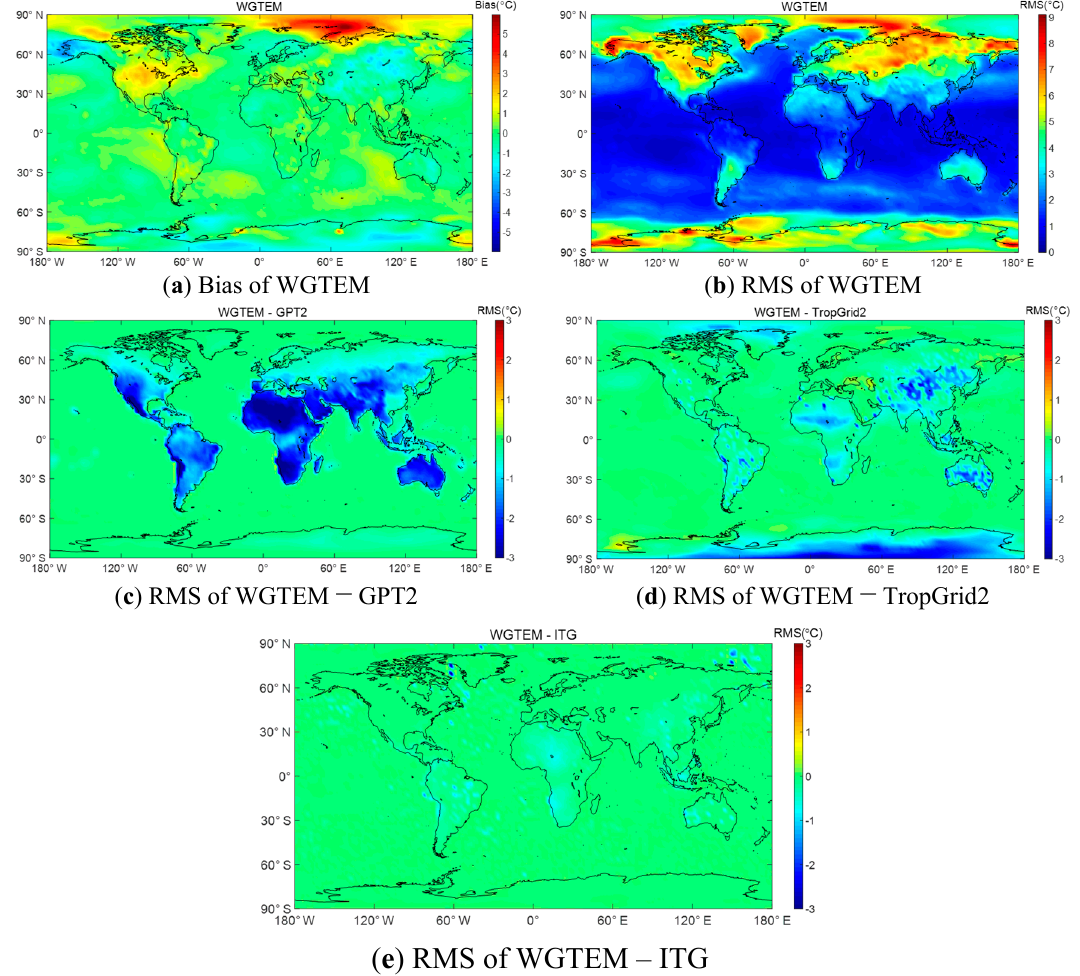
Figure 1. Global distribution of temperature accuracy for Wuhan-University Global Tropospheric Empirical Model (WGTEM) and global RMS differences with reference to other models, validated by ECMWF data.